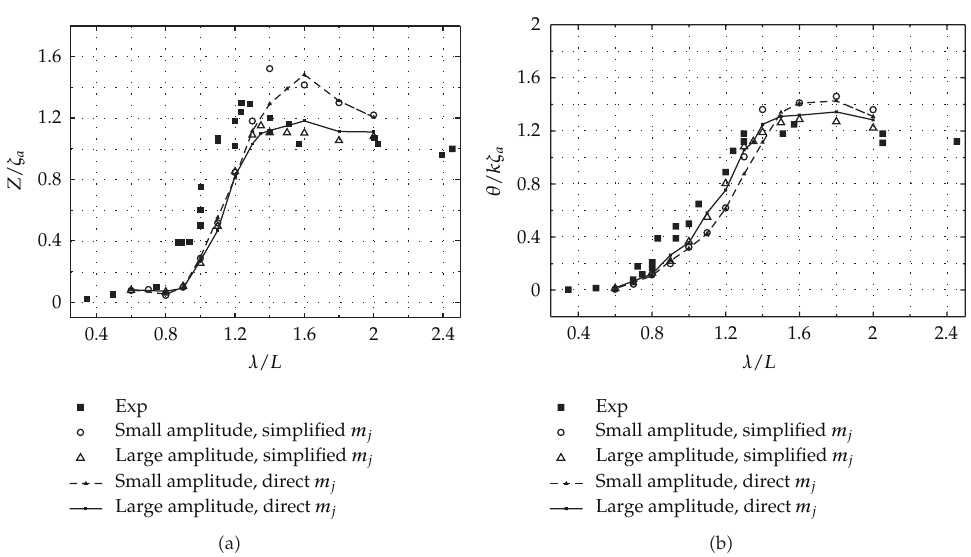
Figure 12: Heave and pitch motion amplitude calculation of S175 ship; F n (cid:7) 0 .